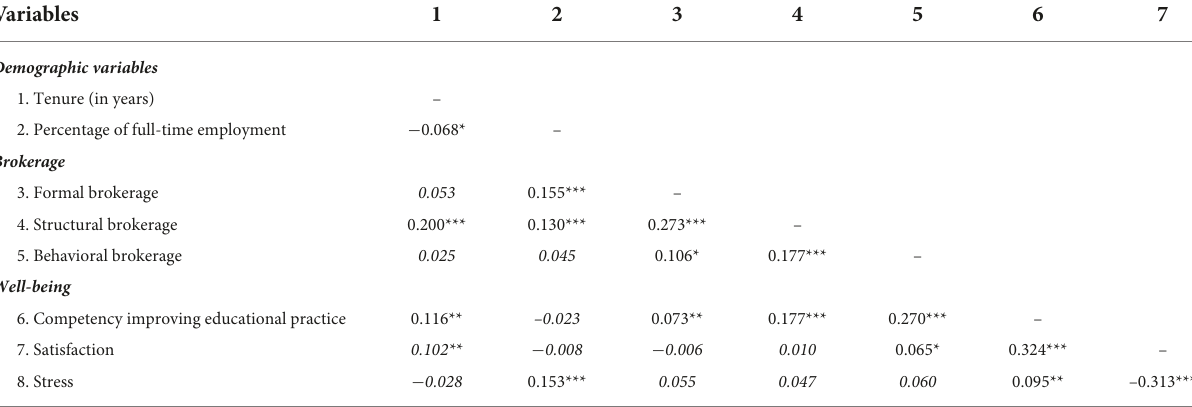
TABLE 2 Intercorrelations between demographic variables, brokerage (formal, structural, and behavioral), and school staff’s well-being. Variables